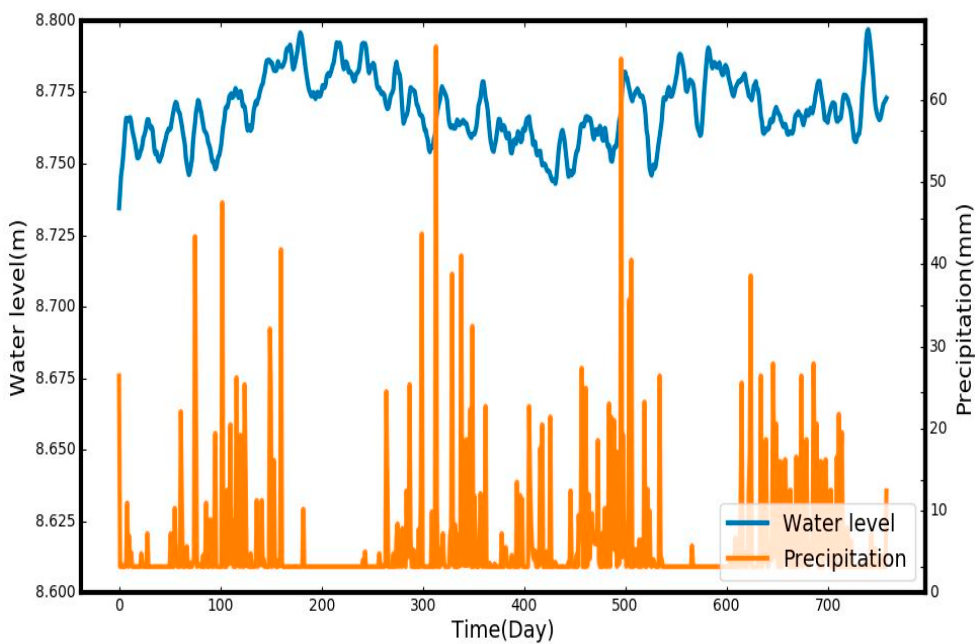
Figure 3. Time series plot of precipitation and groundwater level collected from the Mukarange monitoring borehole.